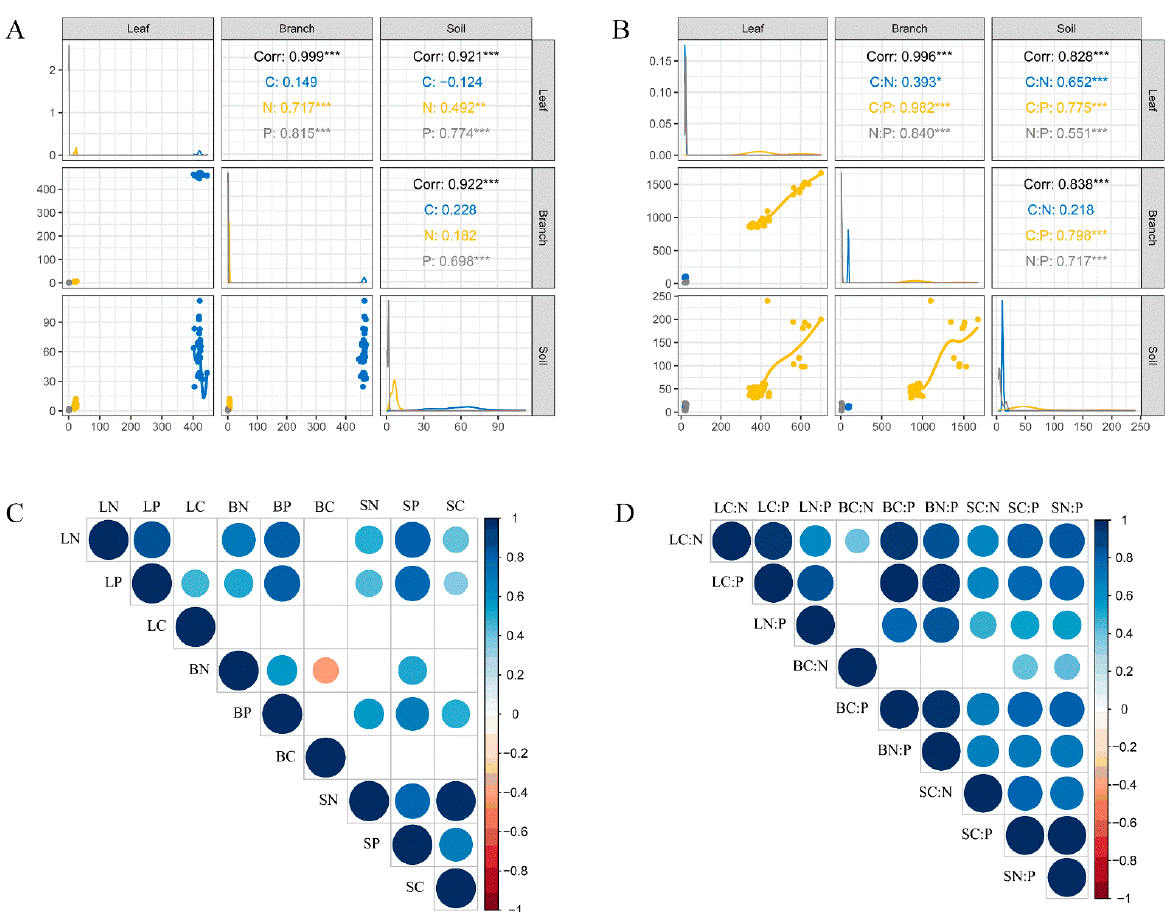
Figure 2. Correlations of C, N, and P stoichiometric characteristics in plant leaf, branch, and soil. Correlations between leaf, branch, and soil ( A , B ), C, N, and P stoichiometry ( C , D ). *, p < 0.05; **, p < 0.01; ***, p < 0.001 .